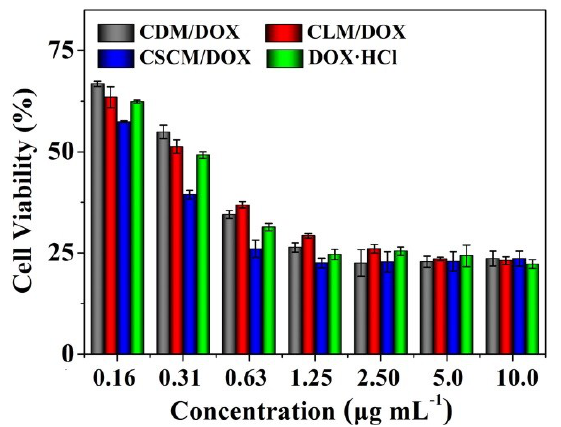
Figure 5. Relative cell viabilities of DOX-loaded micelles toward RenCa cells with free DOX·HCl as control. Each set of data was presented as mean ± SD ( n = 4).